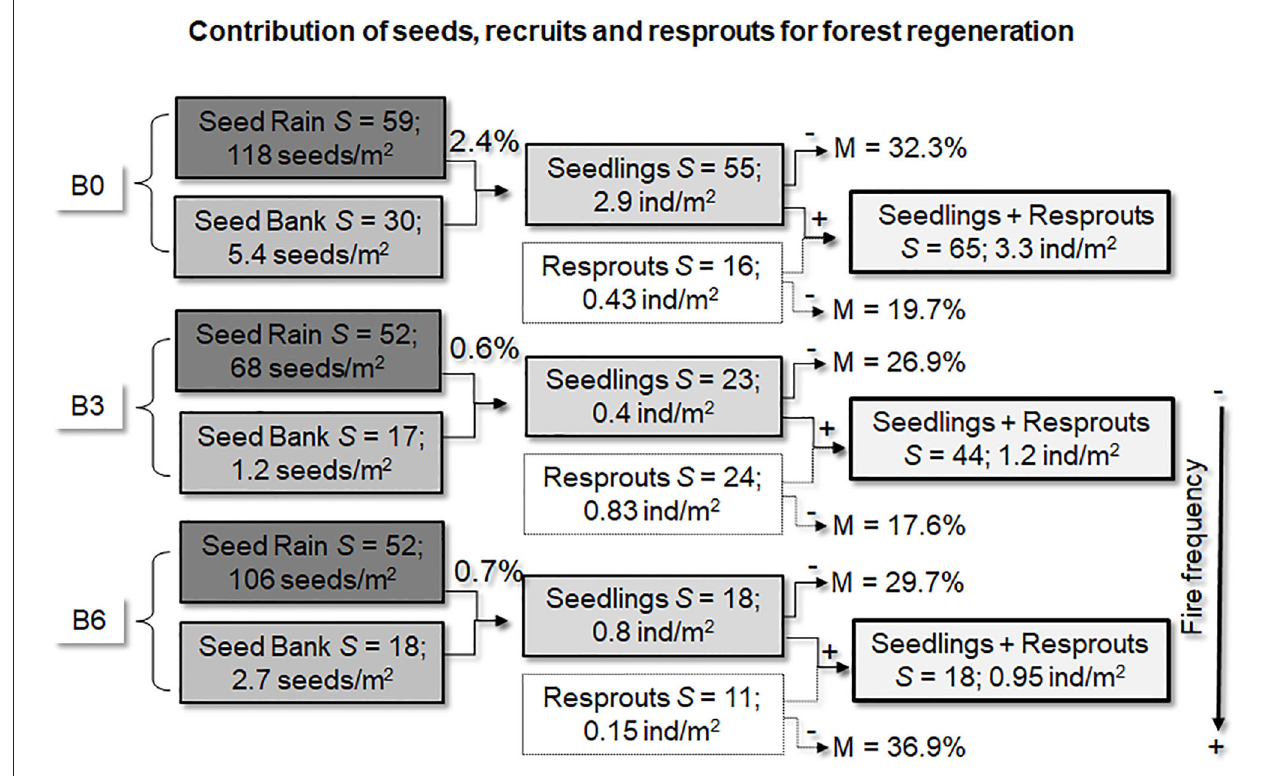
FIGURE 2 | Contribution of seed rain, seed bank, seedlings, and resprouts for forest regeneration, 3 years after fire exclusion. Species richness (S), density (ind/m 2 ), and recruiting rates (% of seedlings by total of seeds arriving) and annual mortality rates (%). B0 (control ) was not burned, B3 was burned three times with 3 years interval, and B6 was burned annually, six